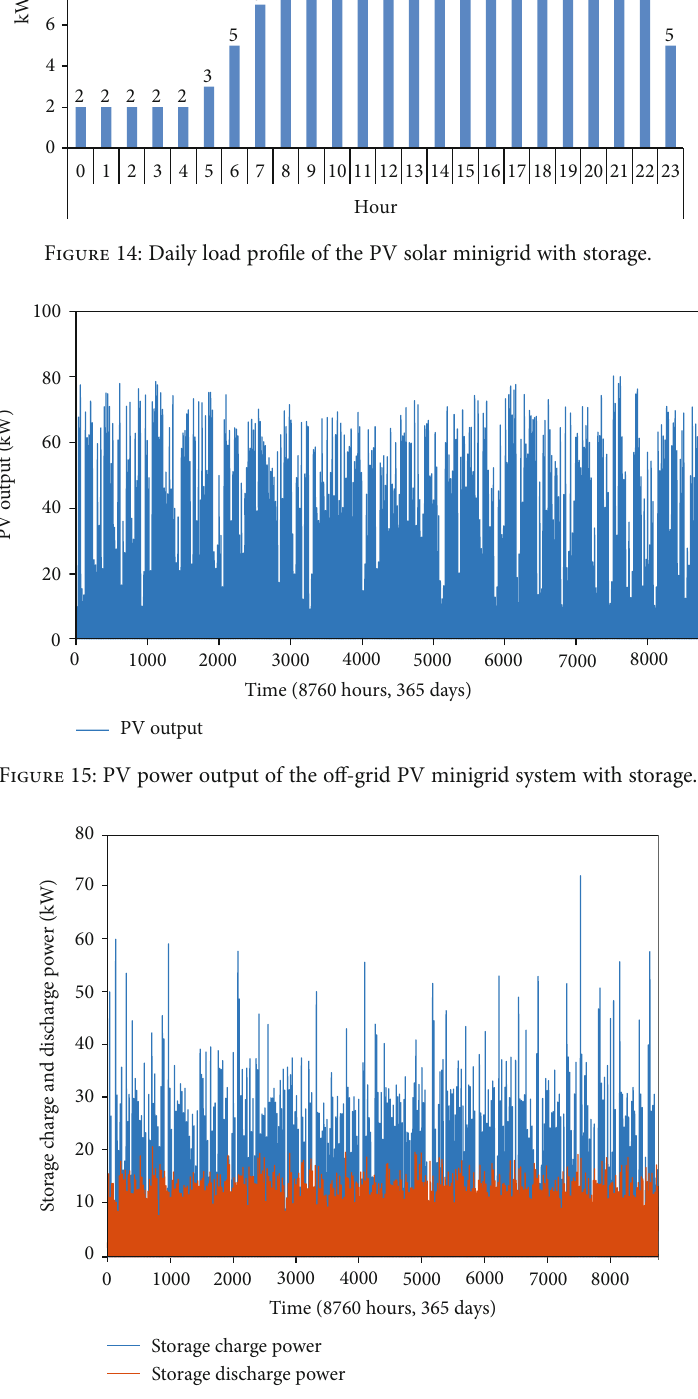
Figure 16: Power storage charge against power storage discharge of the unconnected PV minigrid with